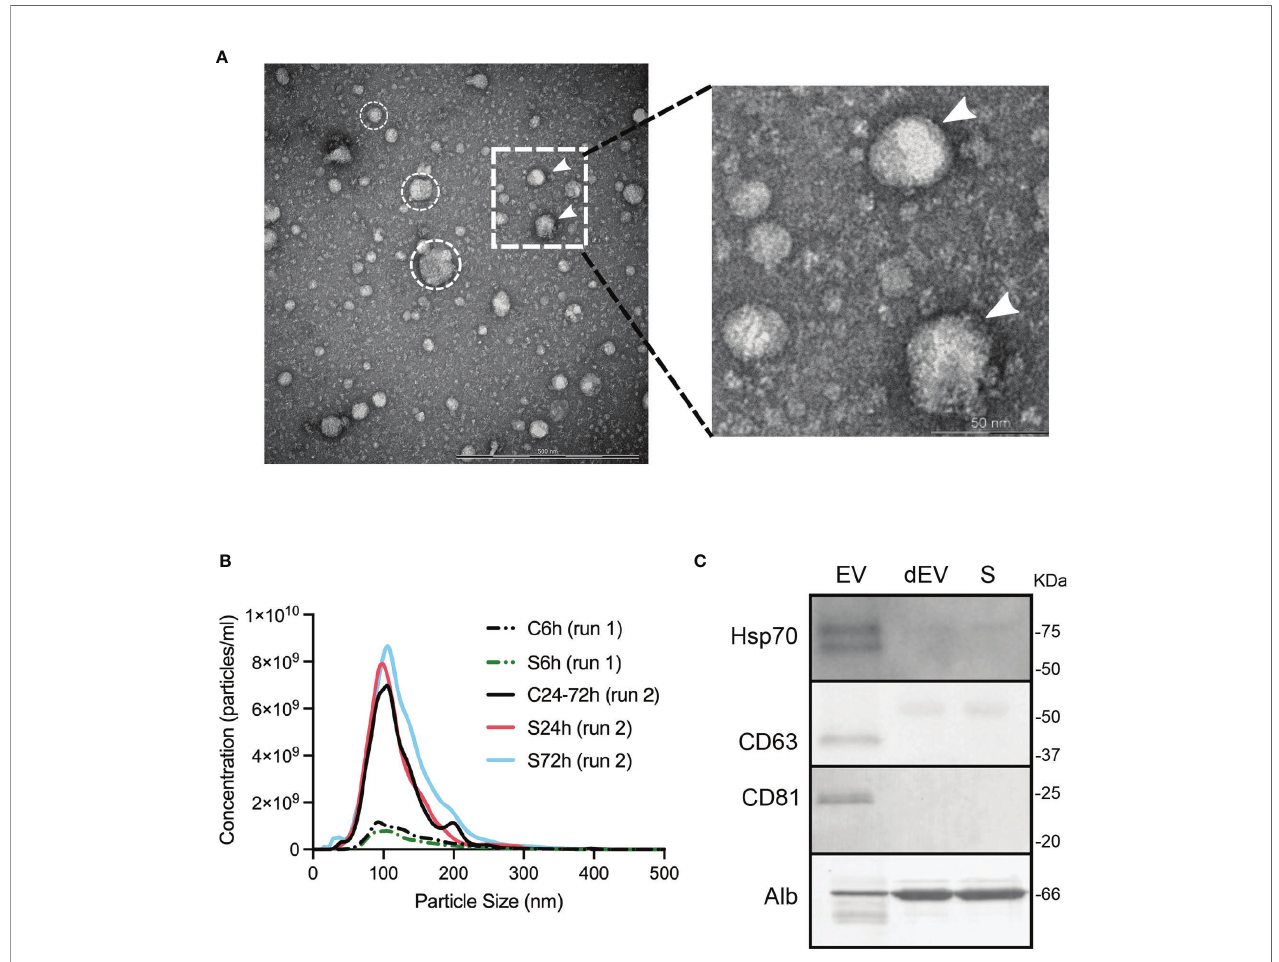
FIGURE 2 | Characterization of circulating EVs. (A) TEM image of the isolated particles, scale bar, 500 nm. Encircled are representative spherical particles. White arrows indicate putative lipid bilayers of EVs. The dotted insert is represented in higher magni fi cation on the right panel. (B) Representative size distribution pro fi le of isolated particles and their concentrations estimated by NTA. However, no differences in the control vs. S6h and the control vs, S24h and S72h comparisons were detected. (C) Western blot identi fi cation of EV enriched proteins and albumin. SDS-PAGE for CD63 western blot was run under non-reducing conditions. dEV, serum depleted of EVs, S,